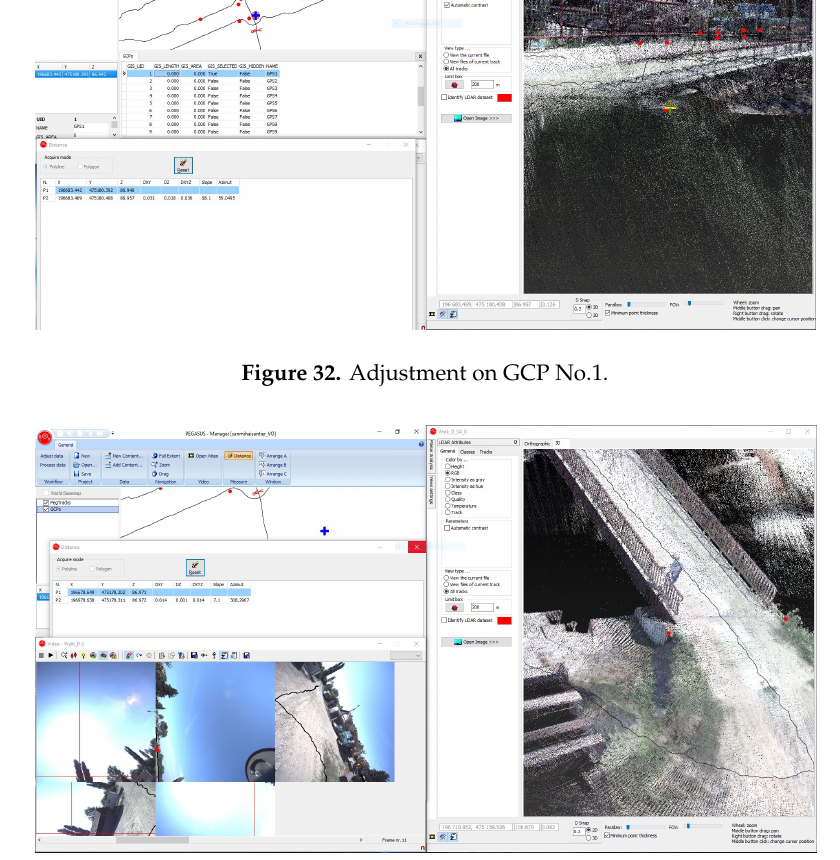
Figure 33. Adjustment on GCP No. 2.